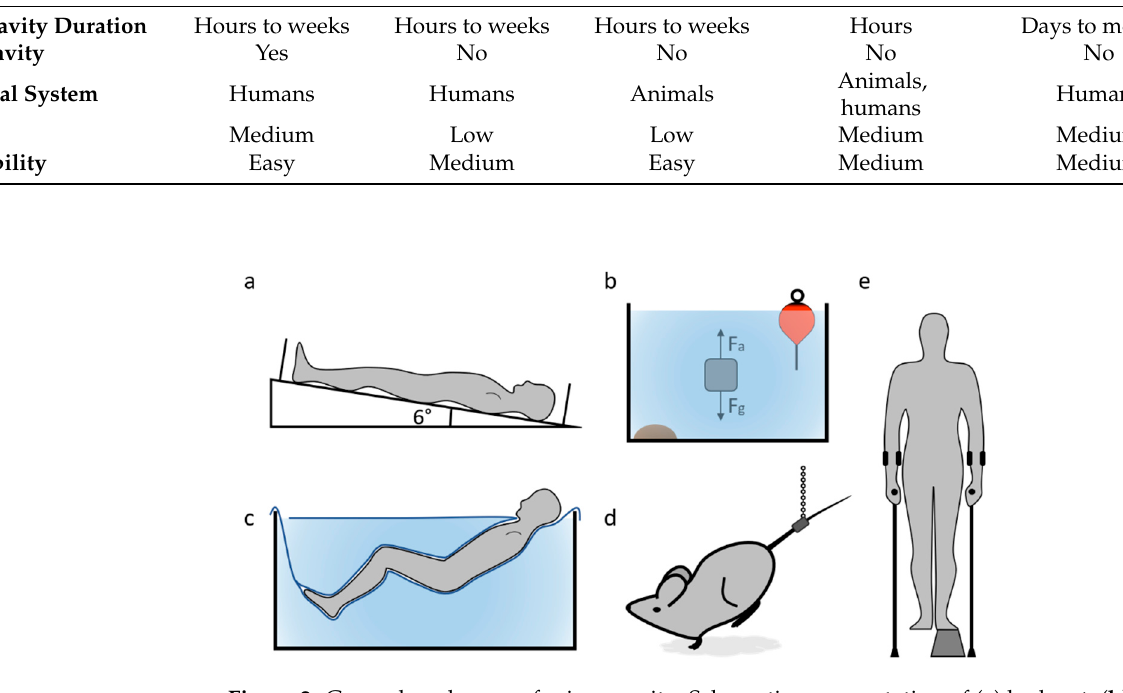
Figure 2. Ground analogues of microgravity. Schematic representation of ( a ) bed rest; ( b ) neutral buoyancy (Fg, gravitational force/weight; Fa, Archimedes/buoyancy force); ( c ) dry immersion; ( d ) rodent hindlimb unloading (HU); and ( e ) unilateral lower limb suspension (ULLS). Microgravity analogues reproduce the effects of microgravity on physiological responses, like muscle and bone loss, and head-ward fluids